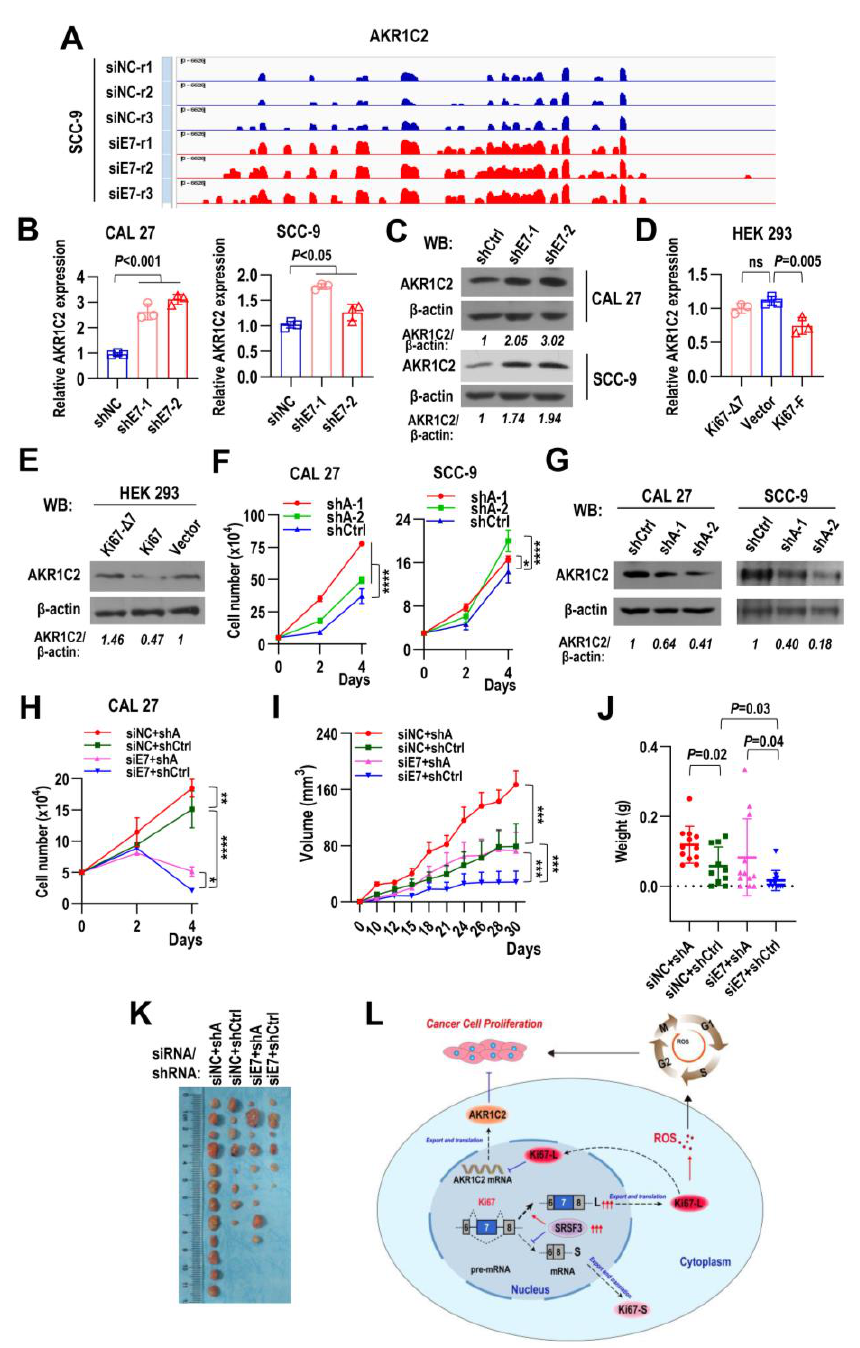
Figure 8. Ki67 exon 7-included isoform promotes tumorigenesis by inhibiting AKR1C2. ( A ) The AKR1C2 mRNA expression level of SCC-9 cells treated with siE7 and siNC was analyzed by IGV software. ( B , C ) AKR1C2 mRNA and protein expression levels in CAL 27 and SCC-9 cells with stable shE7s or shCtrl expression were analyzed by qRT-PCR and Western blot, β -actin served as a loading control. ( D , E ) AKR1C2 mRNA and protein levels in HEK 293 cells with stable Ki67-F, and Ki67- Δ7 overexpression were detected by qRT-PCR and Western blot. Vector is empty control. β -actin served as a loading control. ( F ) CAL 27 cells (5 × 10 4 cells/well) and SCC-9 cells (3 × 10 4 cells/well) with stable shAs or shCtrl expression were seeded into 24-well plates on Day 0. Cells were passed on Day 2. Cell numbers were counted on Days 2 and 4. Data are mean ± SD, n = 3. ( G ) Western blot displayed the knockdown efficiency of AKR1C2. β -actin served as a loading control. ( H ) Downregulation of AKR1C2 partially rescued cell growth inhibition induced by siRNA against Ki67 exon 7 in CAL 27 cells. CAL 27 cells with stable shAs and shCtrl expression (5 × 10 4 cells/well) were seeded